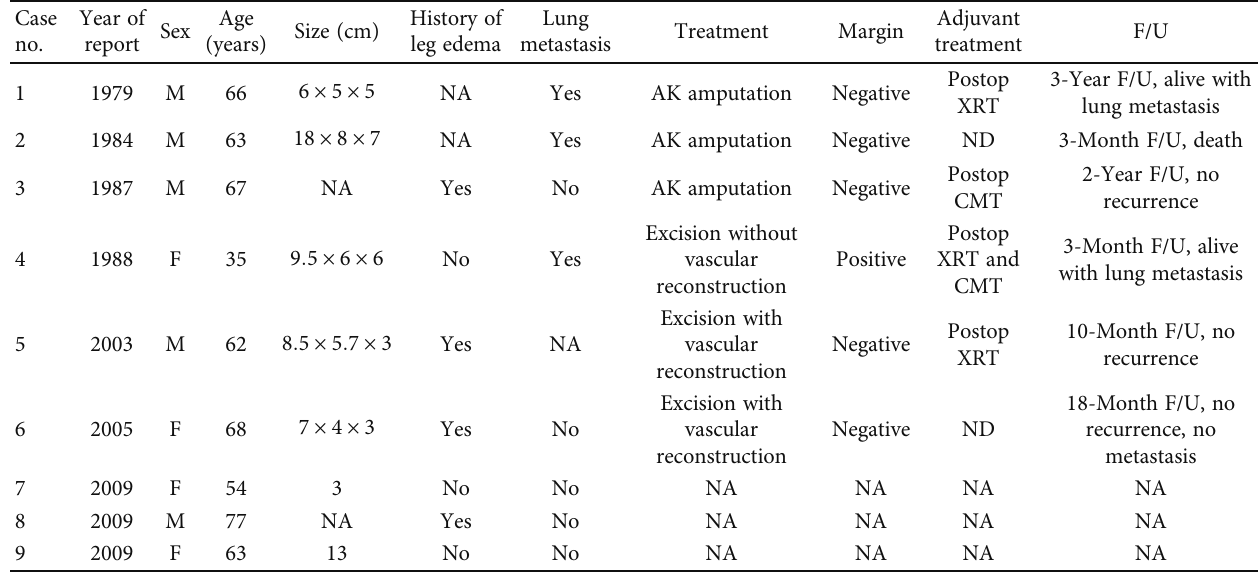
Figure 7: Clinical result at the 16-month follow-up. (a) Good healing of the surgical wound was attained without tumor recurrence. (b) Full range of motion of the involved knee was attained. Table 1: Summarized clinical data of nine patients with leiomyosarcoma of the popliteal